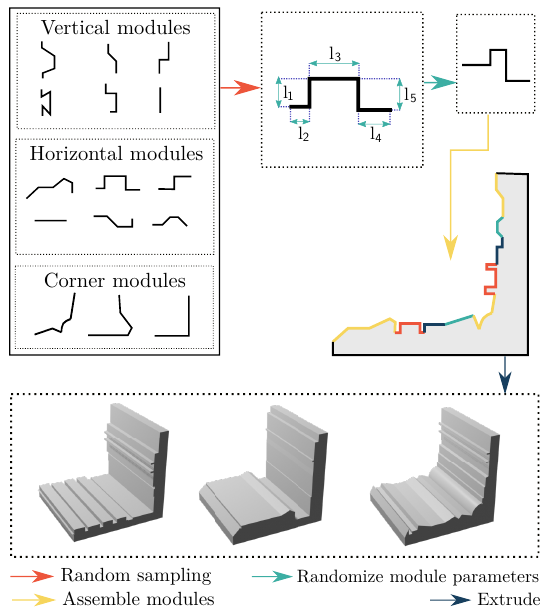
Figure 5: Mesh generation pipeline. A set of predefined modules are randomly sampled and the indi- vidual line lengths of the modules are ran- domized. One corner module, five vertical and five horizontal modules are assembled and extruded to a mesh.